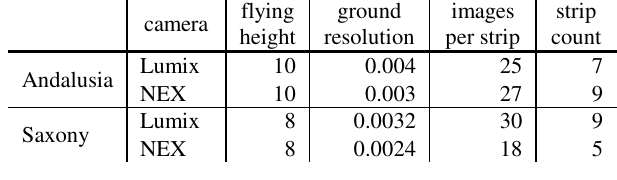
Table 1. Flight planning, unit [m]